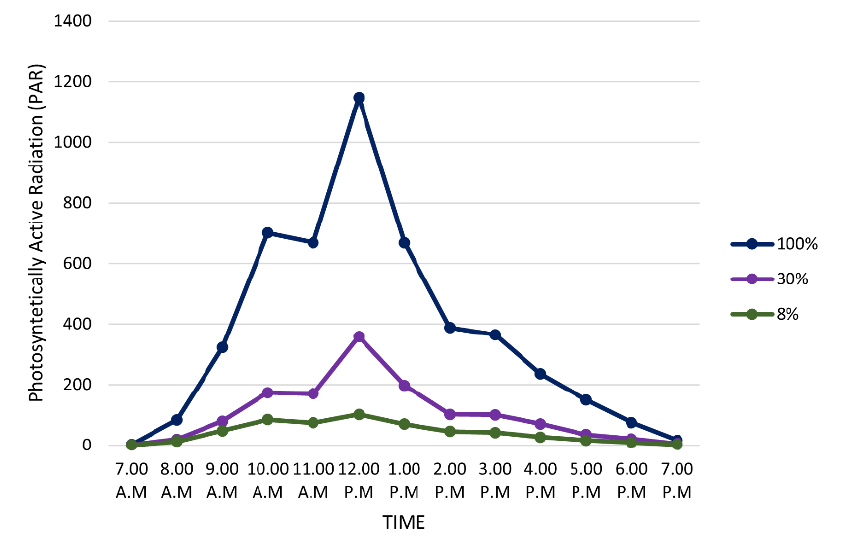
Figure 3. Photosynthetically active radiation (PAR) differences between three levels of light irradi- ance.